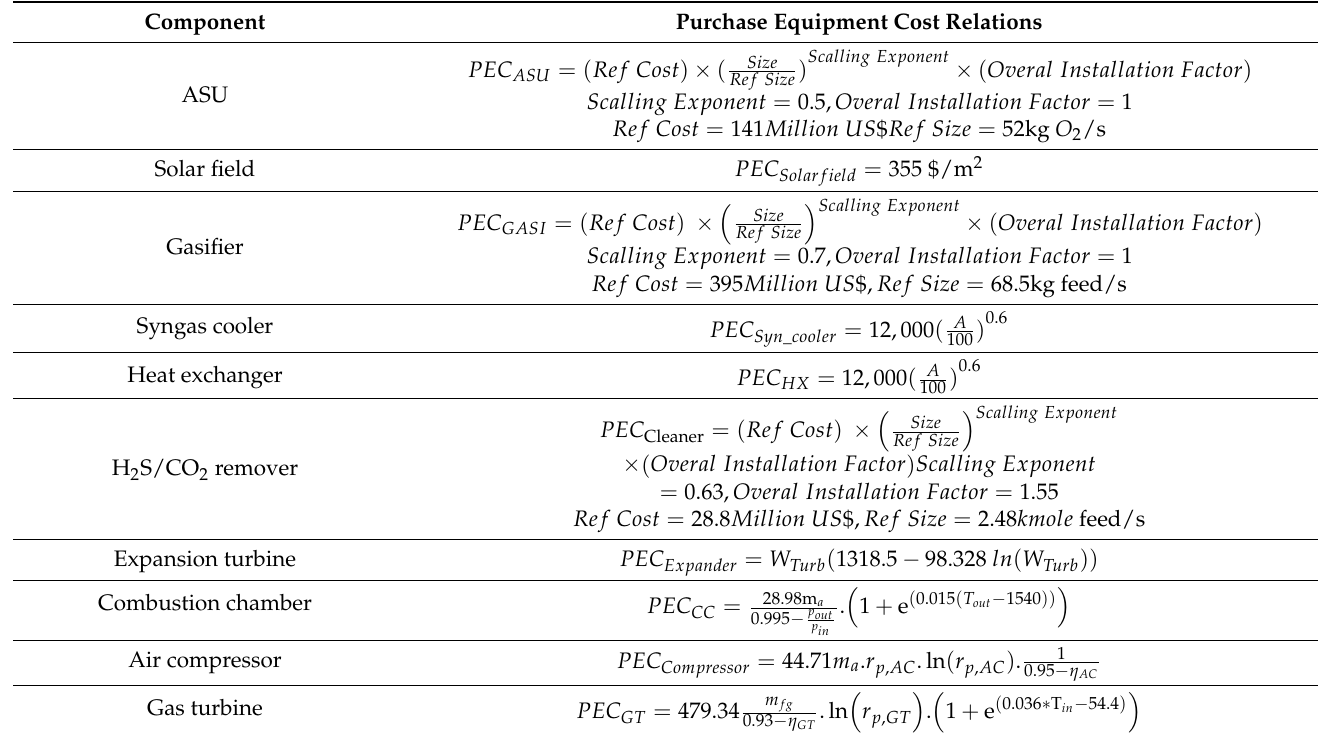
Table A3. Purchase equipment cost for the different ISGC system components